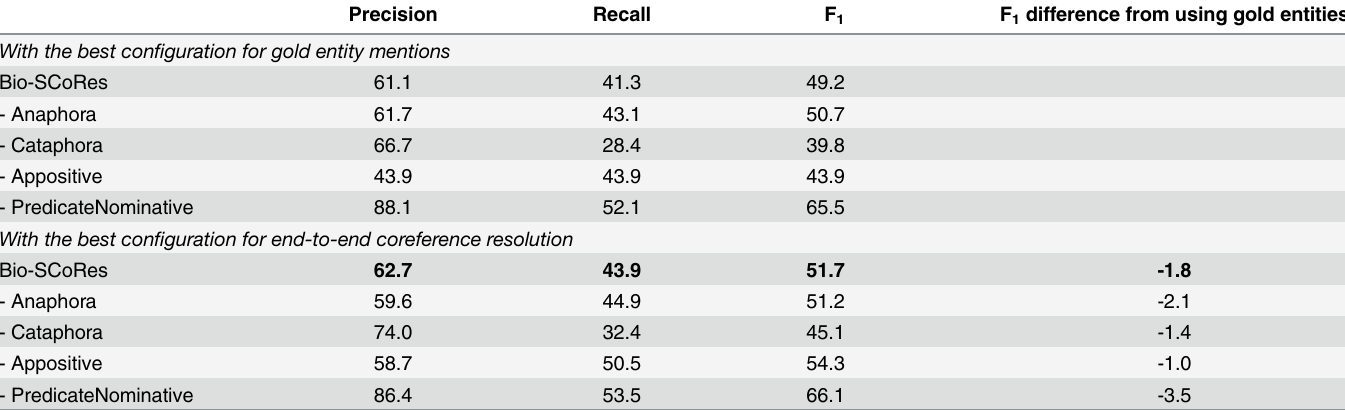
Table 11. Evaluation results on the test portion of SPL coreference dataset using concept recognition/normalization with MetaMap. Precision